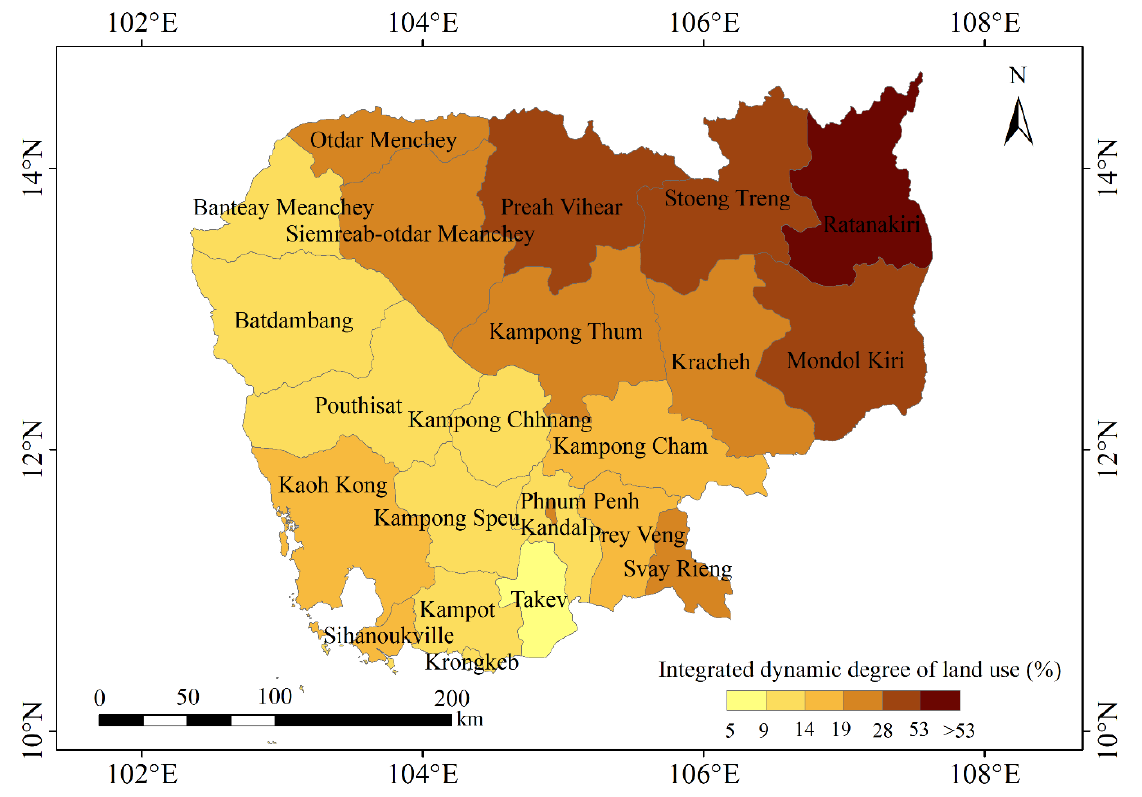
Figure 3. The spatial distribution map of the integrated dynamic degree of LUC in Cambodia from 2000 to 2020.